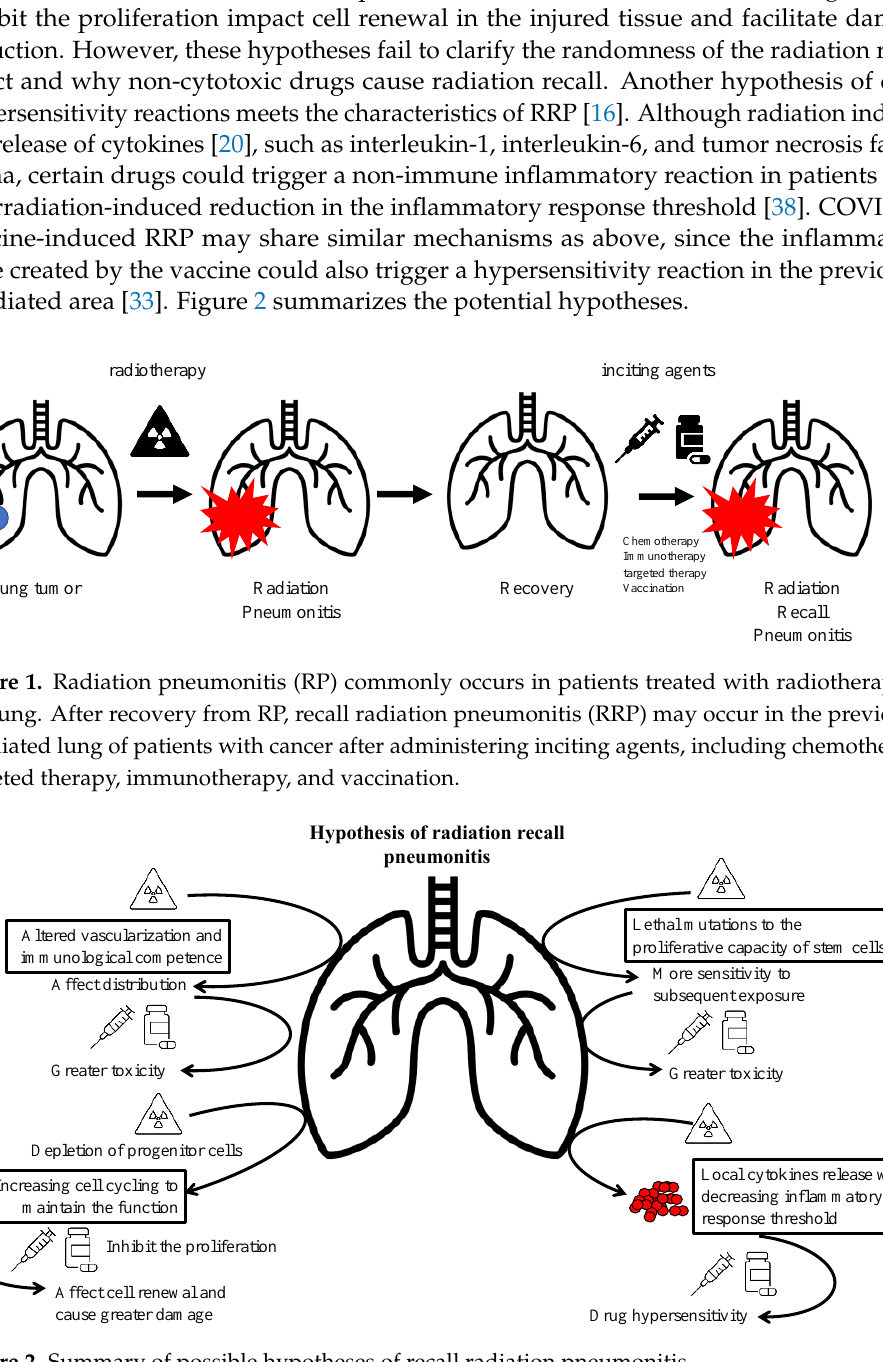
Figure 1. Radiation pneumonitis (RP) commonly occurs in patients treated with radiotherapy to the lung. After recovery from RP, recall radiation pneumonitis (RRP) may occur in the previously irradiated lung of patients with cancer after administering inciting agents, including chemotherapy, targeted therapy, immunotherapy, and vaccination.